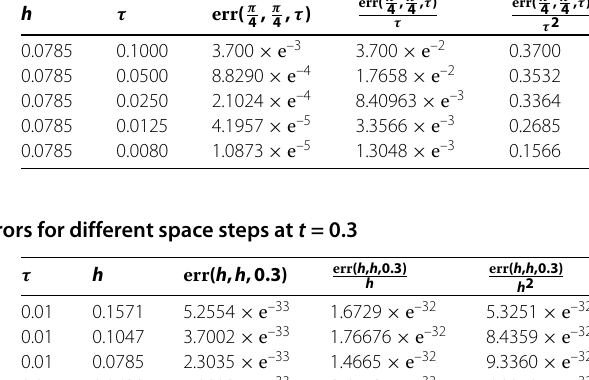
Table 1 L ∞ -errors for different time steps at x = π